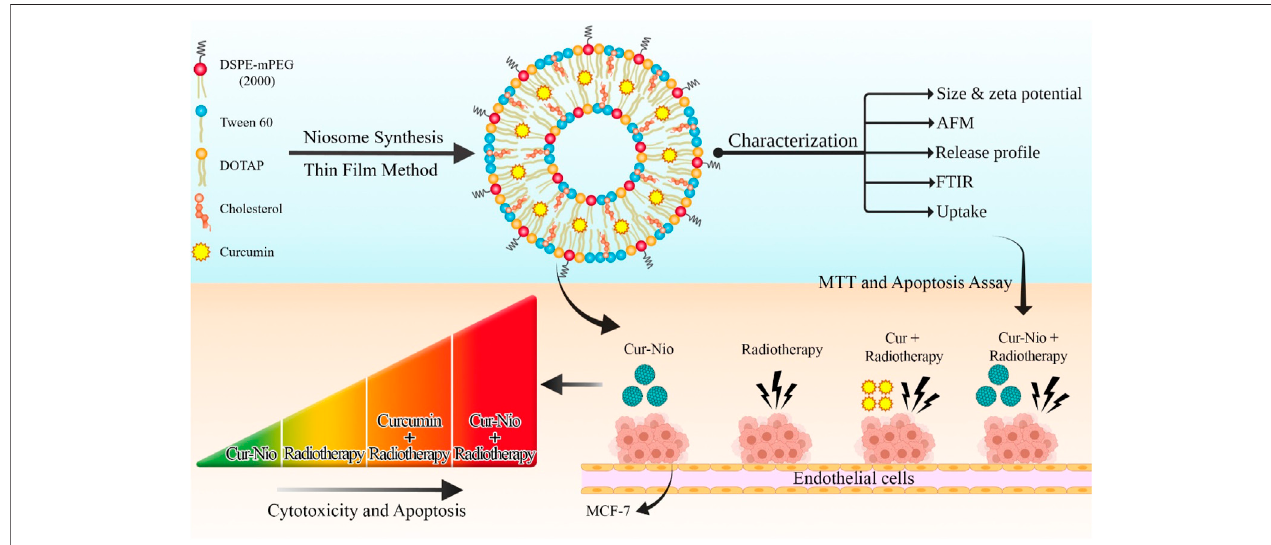
FIGURE1| Schematic viewofsynthesizingthePEGylated niosomalnanoformulation based on Tween60, cholesterol, DOTAP,and DSPE-PEG at ratios of70:30: 10:5, respectively. The process of curcumin encapsulation was performed by the thin- fi lm hydration method and then used in combination with radiotherapy.